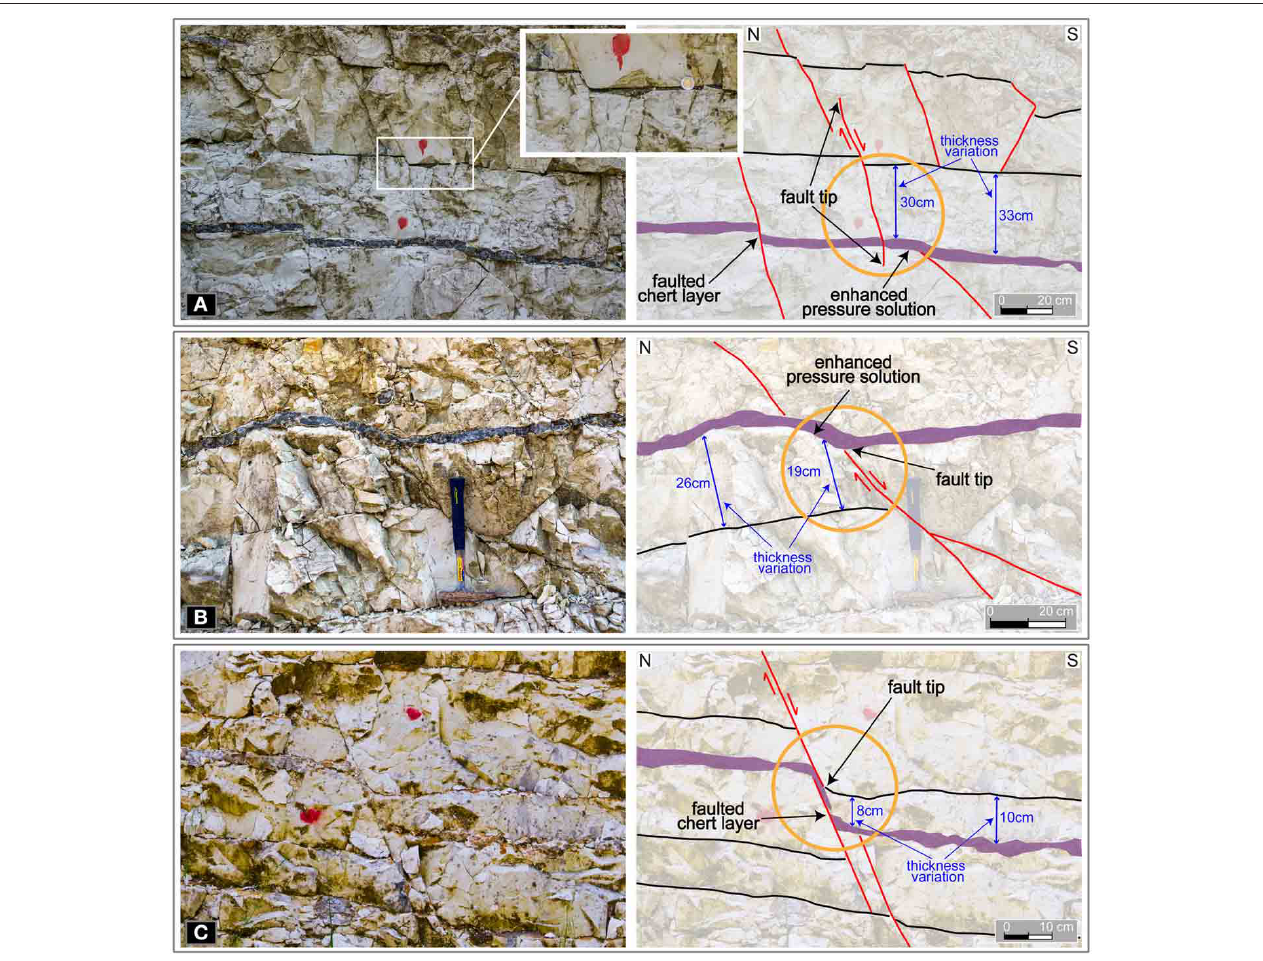
FIGURE 10 | (A–C) Photographs (left) and related line drawing (right) of three instances of fault terminations from the study outcrop in the Cingoli anticline hinge. In all instances, note the tapering (accomplished through bed-parallel pressure solution) of carbonate beds in approaching the compressional quadrant of normal fault tips (see the fault compressional quadrants in Figure 11A ). Inset in (A) shows a close-up view of a bed-parallel pressure solution seams with a thick layer of greenish clayey residual